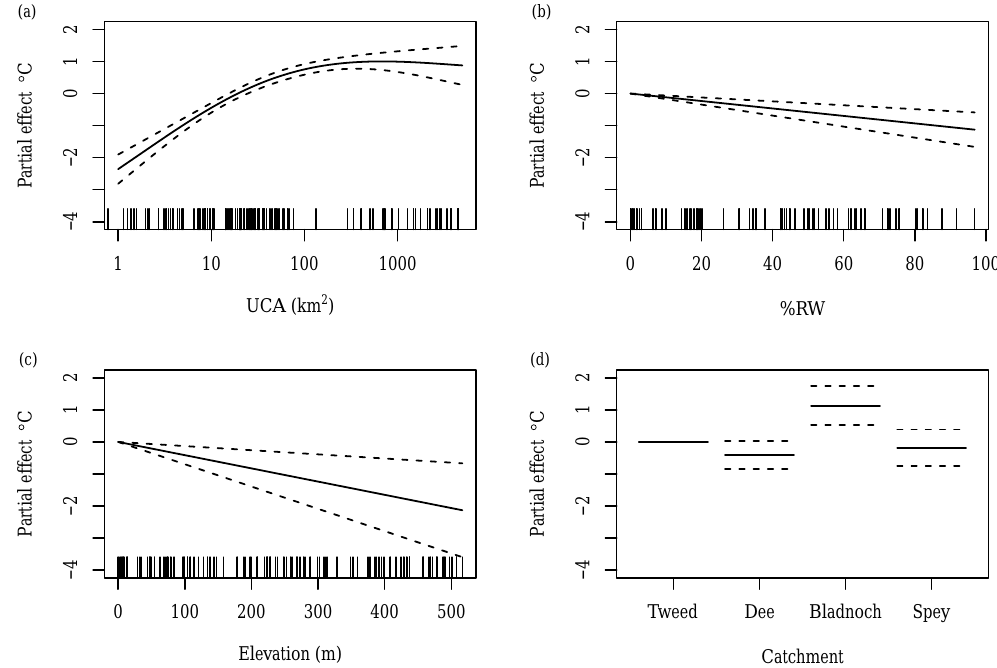
Figure 7. Multi-catchment LS model effects with pointwise 95% confidence bands: (a) UCA, (b) %RW, (c) Elevation and (d)